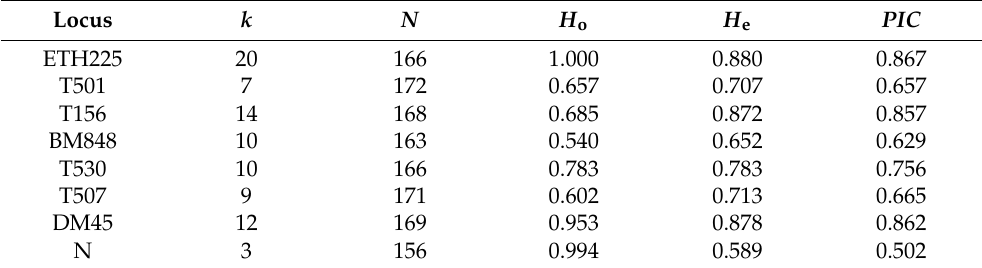
Table 3. The ampli fi cation information for eight microsatellite primers.